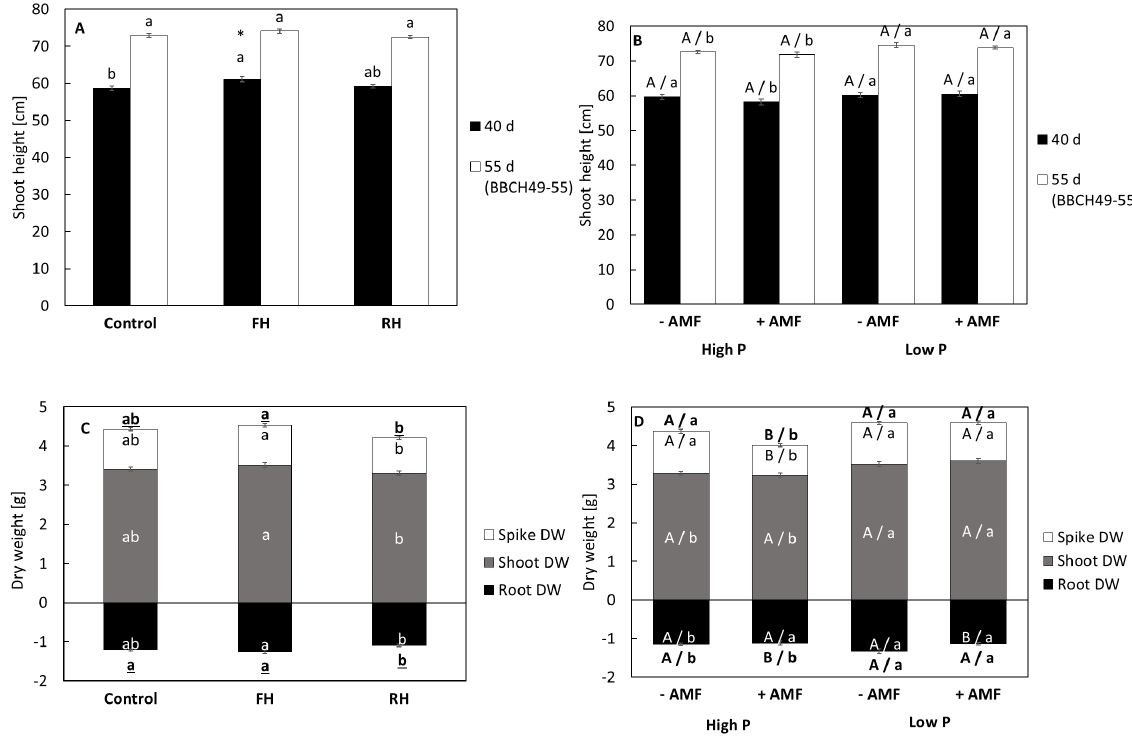
Fig. 1. Effect of experimental treatments on barley growth in the pot experiment. A,C: Effect of hydrolysates (FH, chicken feather hydrolysate; RH, reference hydrolysate) averaged over the factors “P-level” and “AMF”. B,D: Effect of P-level and AMF averaged over the factor “hydrolysate”. An asterisk indicates a significant effect of hydrolysate at p < 0.05 (*) compared to the corresponding control. Different letters indicate statistically significant ( p < 0 . 05 ) differences between treatments. B and D: Capital letters indicate significant effects of AMF within given P-level, and small letters indicate significant effects of P-level within particular AMF-treatment. C and D: Small letters above bars indicate significant differences in DW of roots, shoots (excluding spikes) and spikes. Bold letters above bars indicate differences in the aboveground DW (shoots + spikes) and bold letters below bars indicate significant differences in total plant weight (shoots, spikes and roots). Below-ground biomass is shown as negative, above-ground biomass is shown as positive values. BBCH = growth stages according to Zadoks et al. 1974